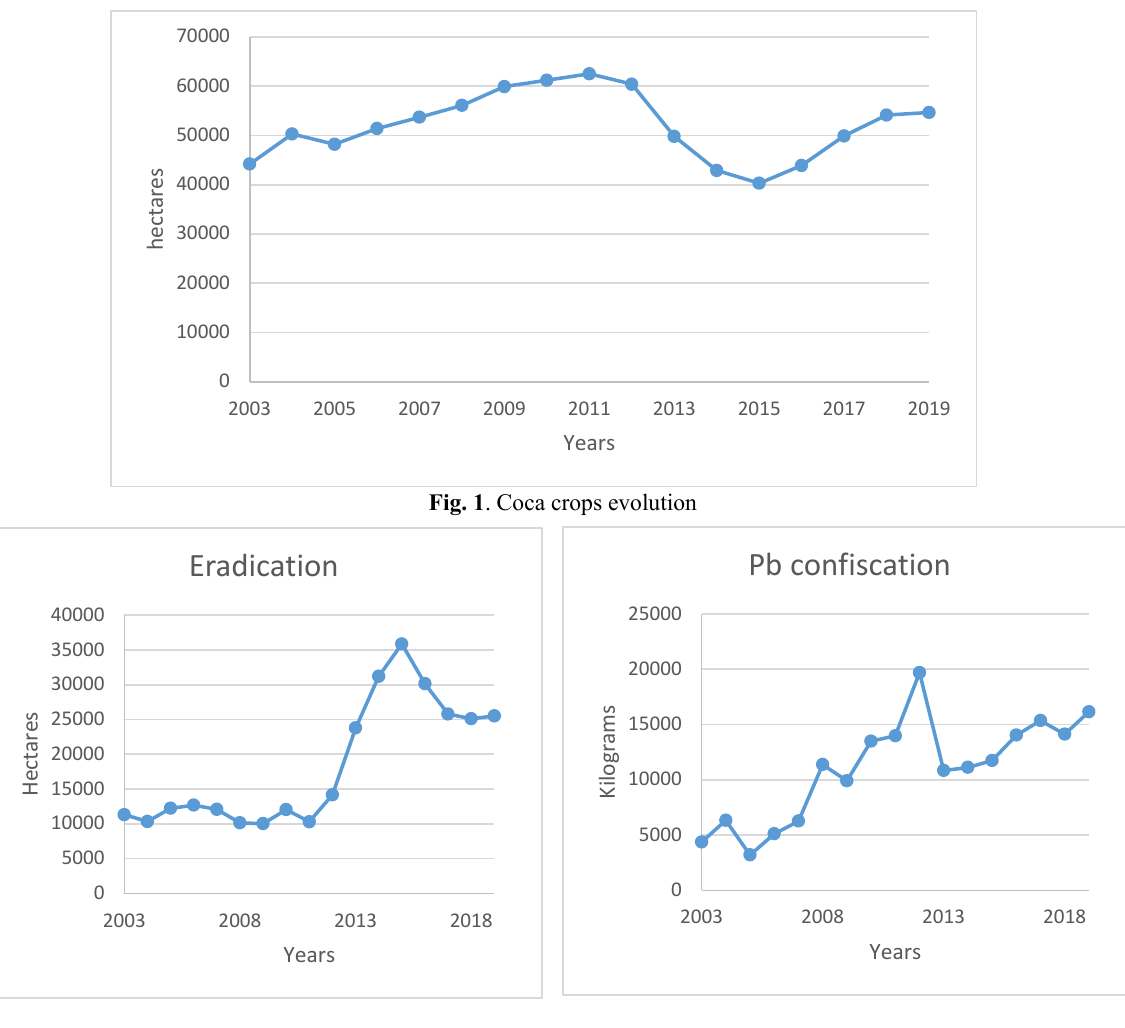
Fig. 2. Eradication Fig. 3. Pb confiscation Lasso estimation LASSO technique